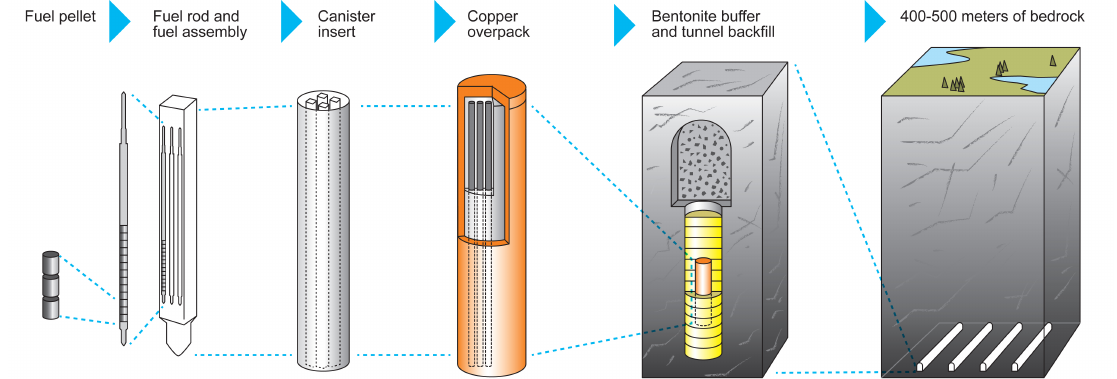
Figure 1. Multiple release barriers of the KBS-3 concept—Posiva Oy